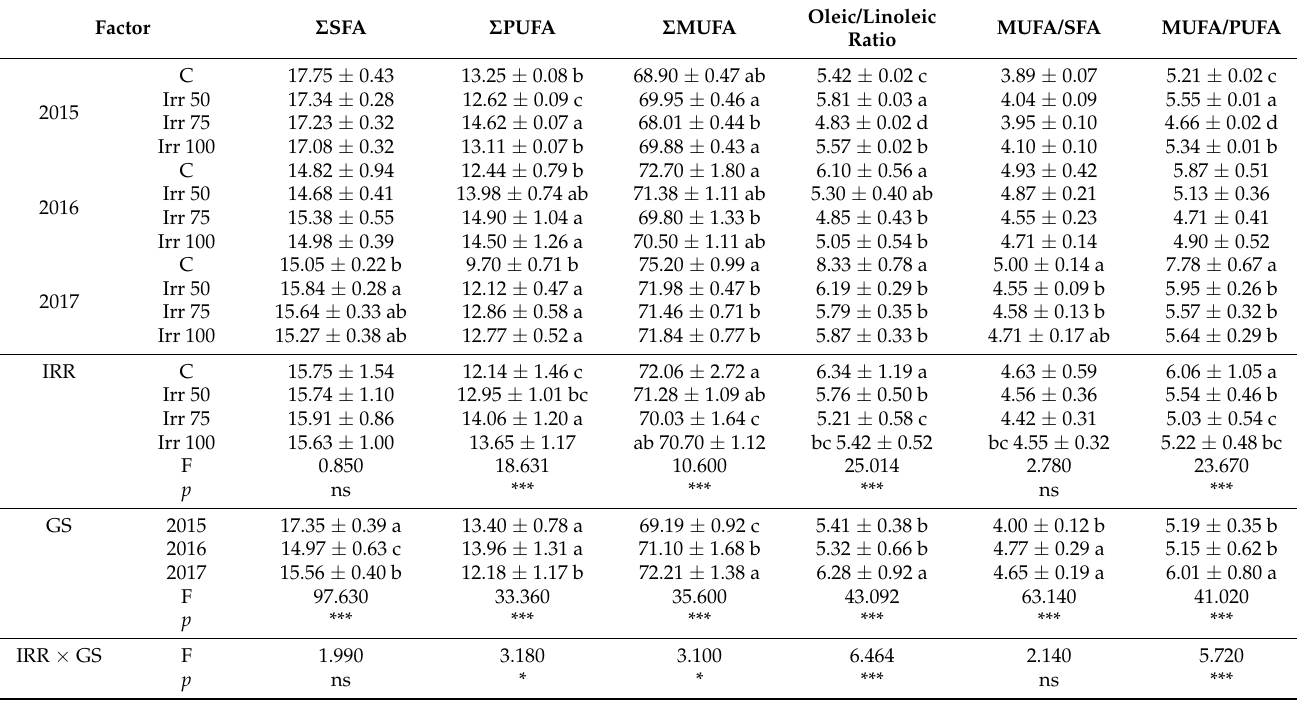
Table 7. Effect of different irrigation levels on fatty acids grouped upon unsaturation degree and their ratios in virgin olive oils in three experimental